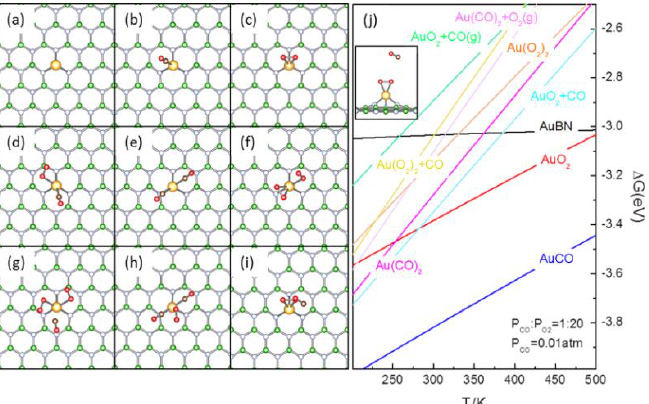
Figure 1. The calculated atomic structures (a − i ) and temperature dependence of ∆G ( j) for the potential reaction species formed over AuBN in CO oxidation. Please see the context for the notation of structures. ∆G was calculated with respect to B -vacancy on h-BN, Au atom at P CO = 0.01 atm and P CO /P O2 = 1:20. The inset in ( j ) is the sideview of ( i ). In ( a ) – ( i ), the B, N, C, O and Au atoms are in green, light blue, brown, red and gold, respectively.